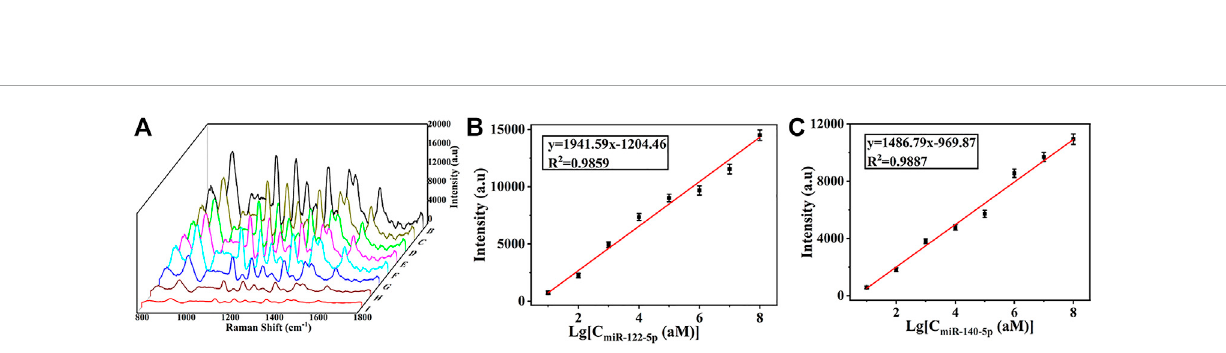
FIGURE 7 (A) SERS spectra of miR-122-5p and miR-140-5p with different concentrations in serum (10 aM, 100 aM, 1 fM, 10 fM, 100 fM, 1 pM, 10 pM, and 100pM). (B) Calibration curveofpeak intensities at1,133 cm − 1 versus logarithm ofmiR-122-5p concentration and (C) calibrationcurveofpeak intensities at 1,602 cm − 1 versus logarithm of miR-40-5p concentration.